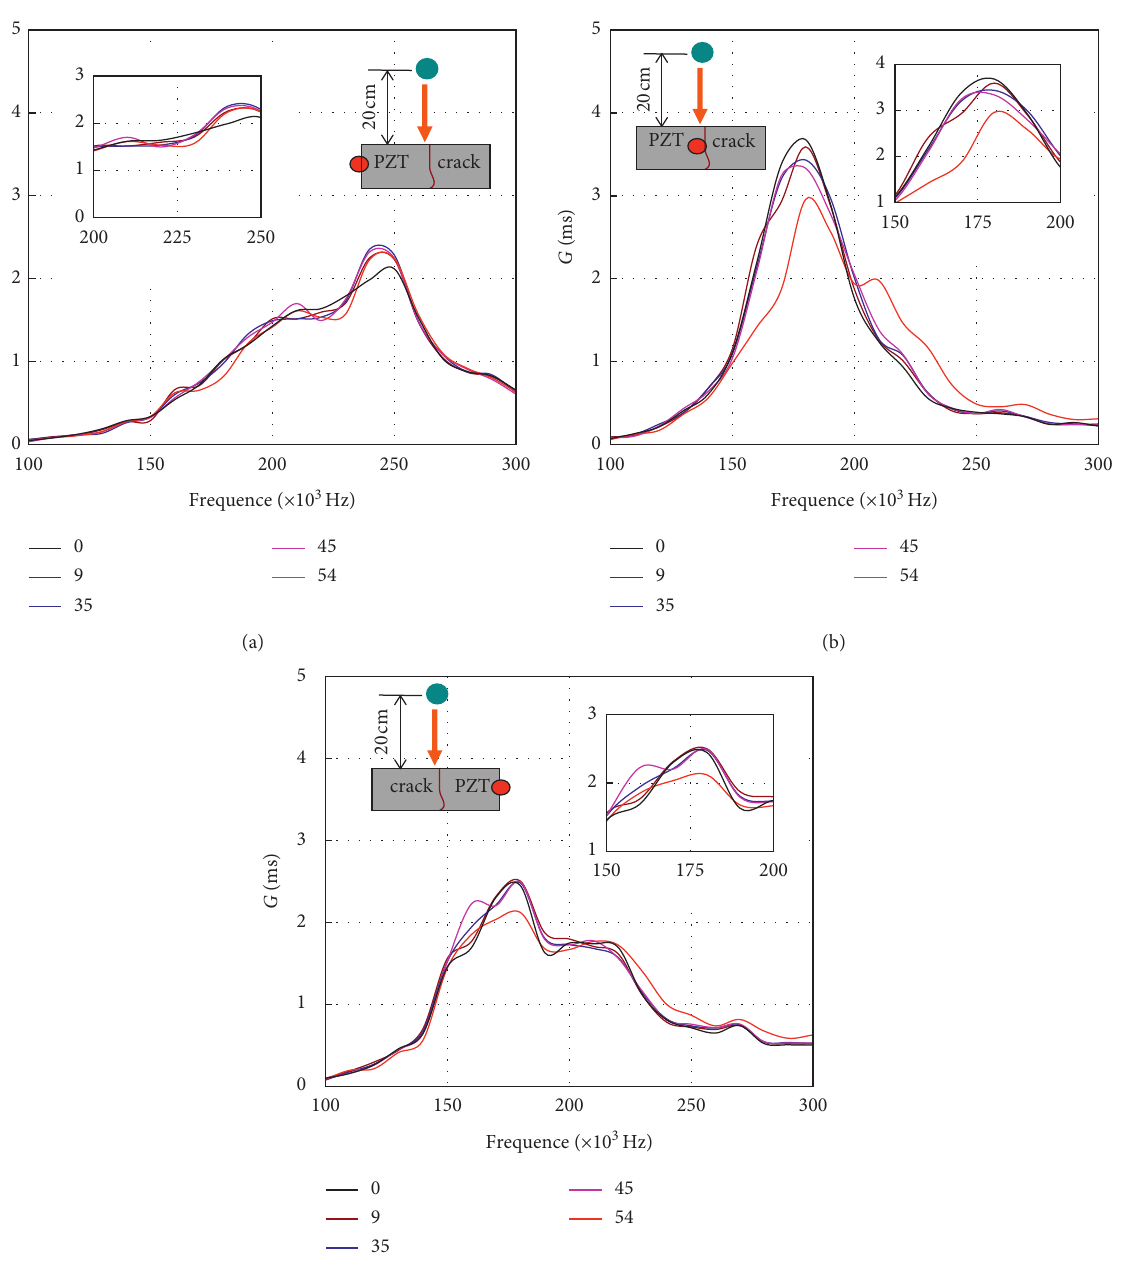
Figure 6: Conductance signal test results with 20cm impact height: (a) − 15 cm; (b) 0 cm; (c)